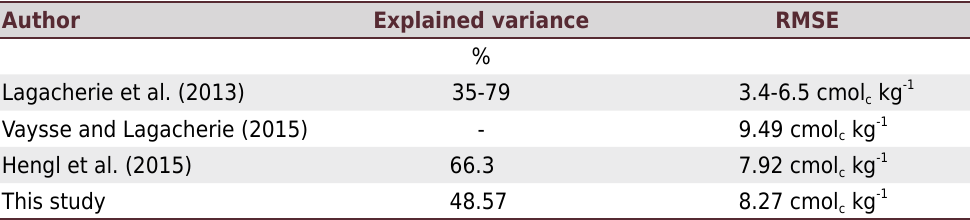
Table 3. Results from previous studies that used the Random Forest model to predict soil cation exchange